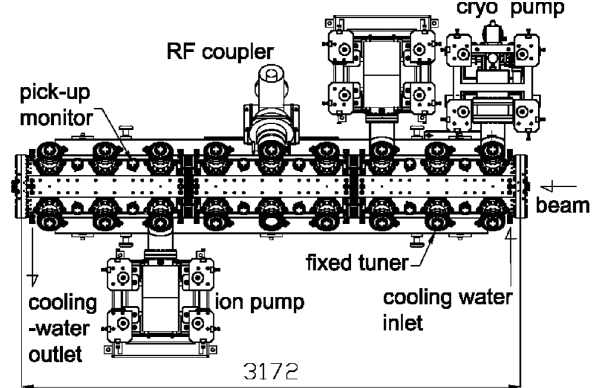
FIG. 1. Schematic of RFQ II (top view).